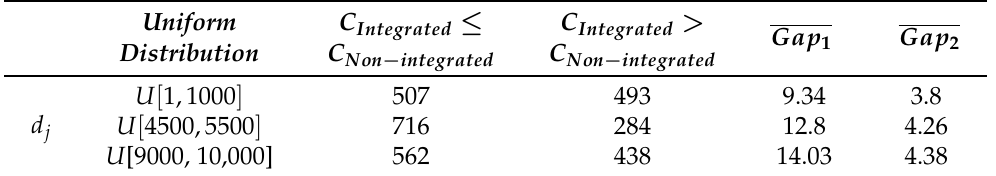
Table 8. Comparison between the integrated and the non-integrated policies when the production rate was sufficient to ensure the feasibility of the non-integrated